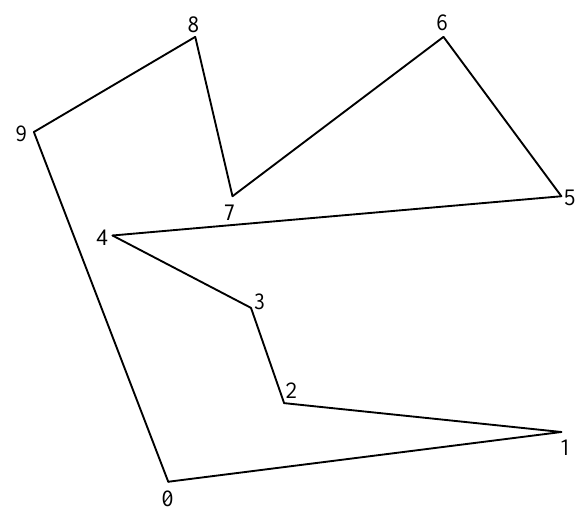
Figure 2: The original polygon